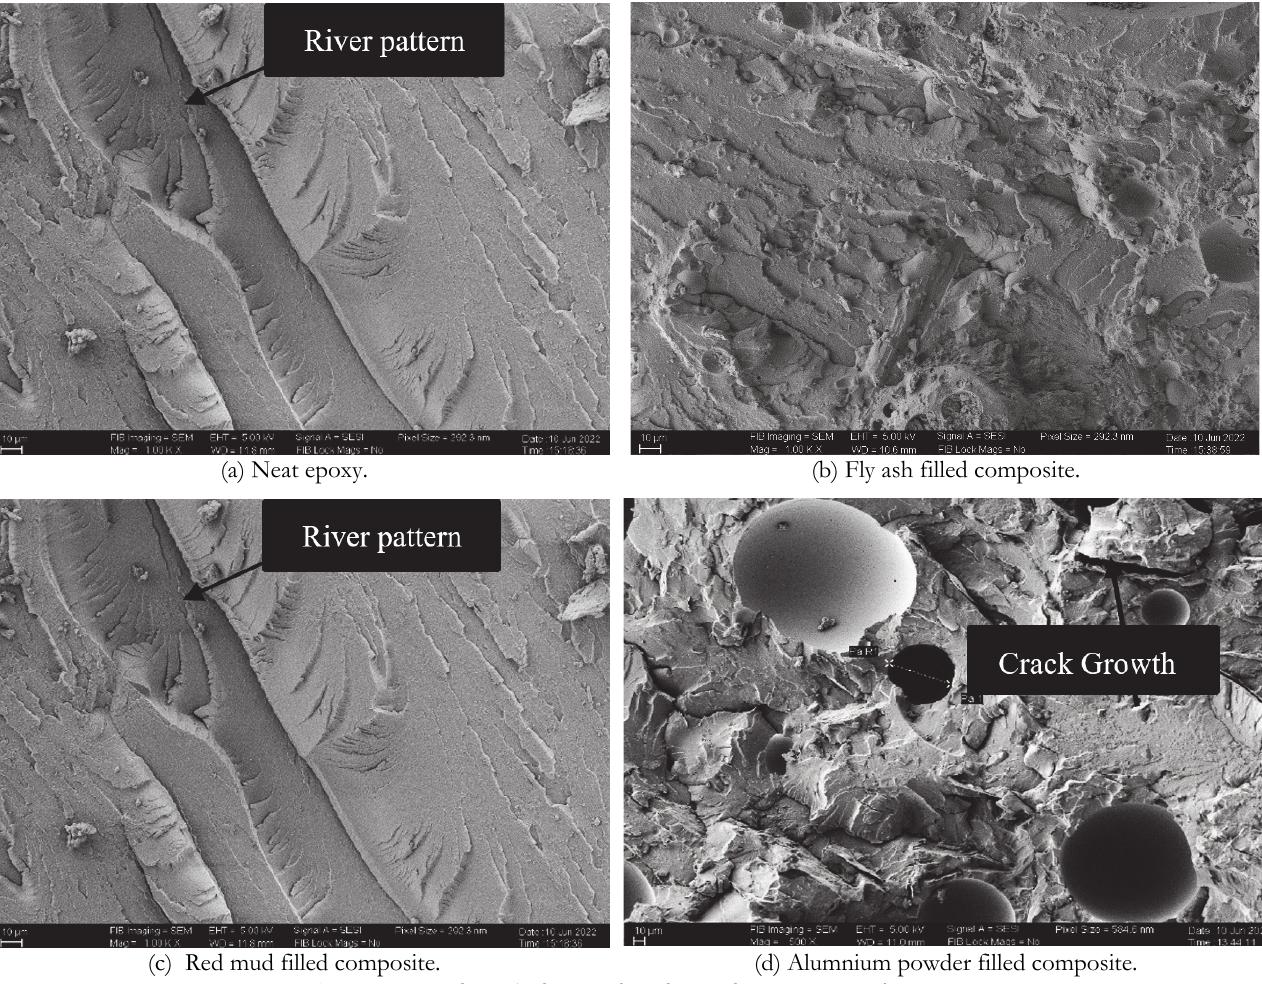
Figure 5: SEM images of tensile fractured surfaces of neat epoxy and its